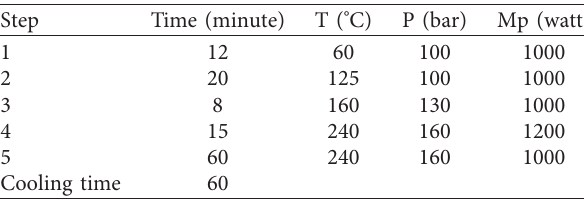
Table 1: Microwave program for sample